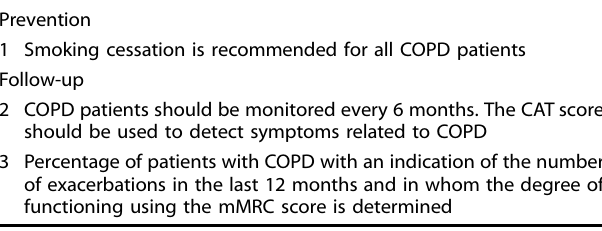
Table 3. Recommendations and QI on COPD care, belonging to the core set of recommendations and QIs as de fi ned by the expert panel, but not yet translatable into measurable